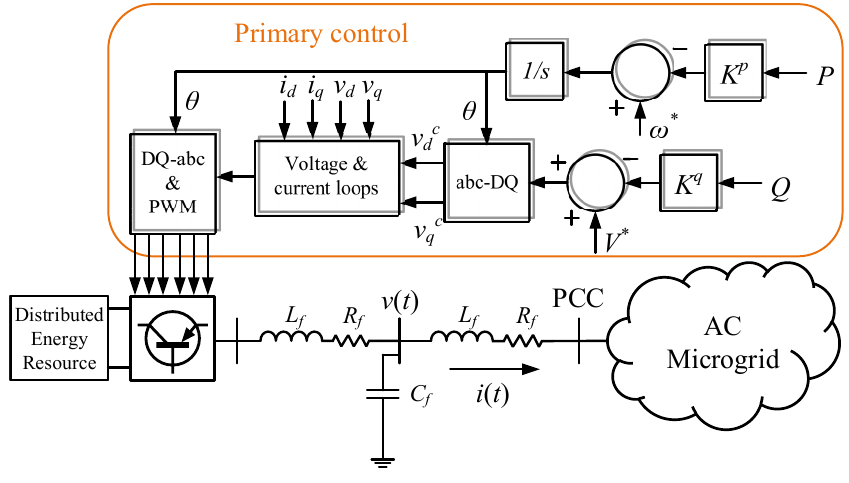
Figure 1. Droop control block